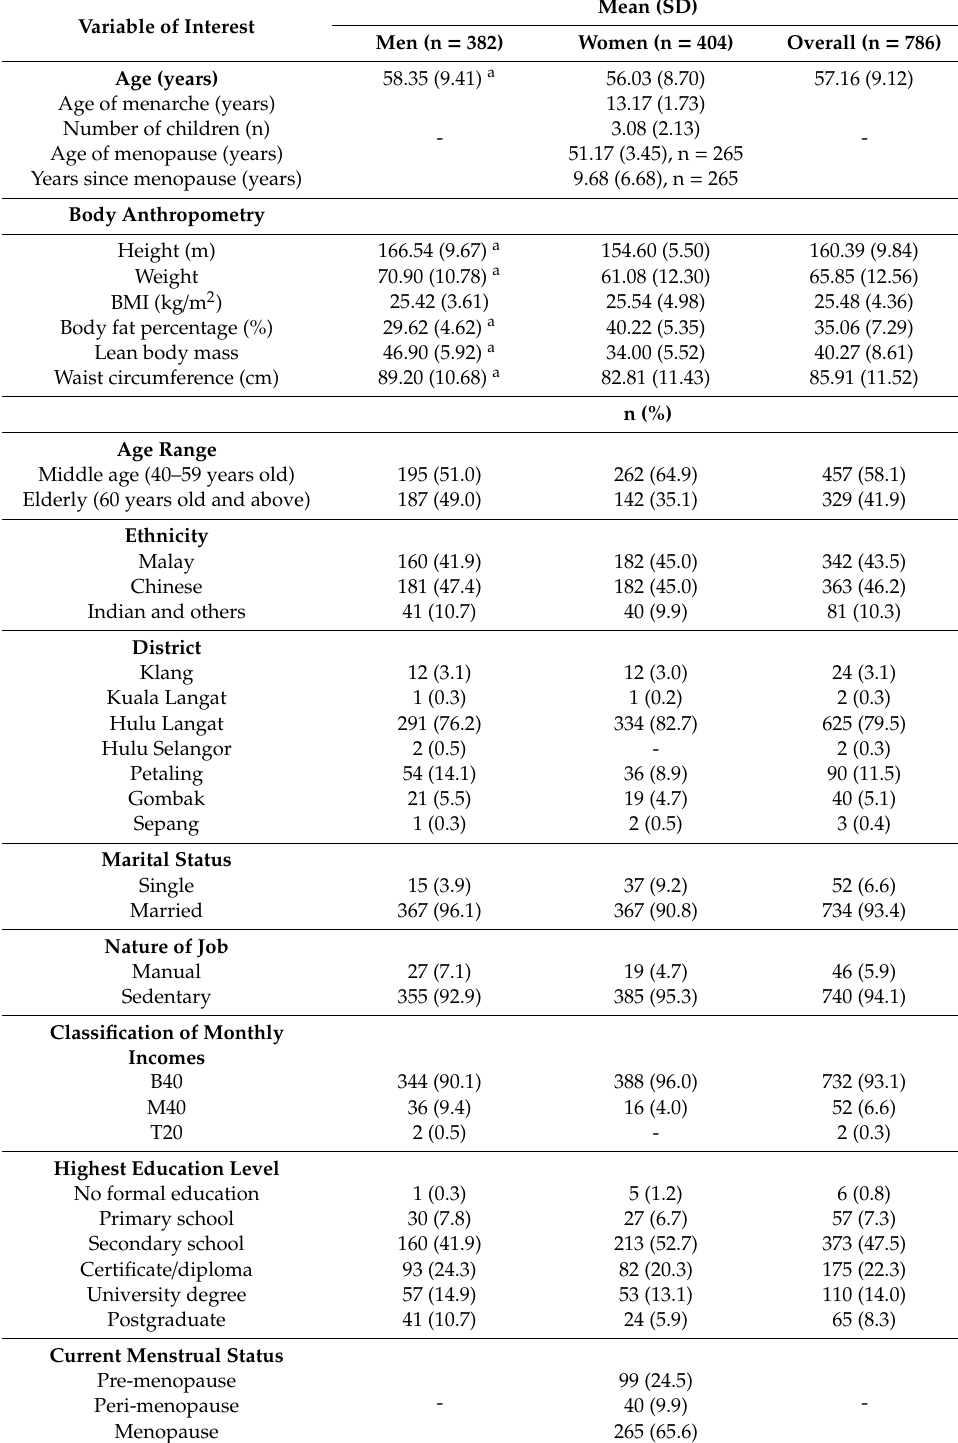
Table 1. Characteristics of the study